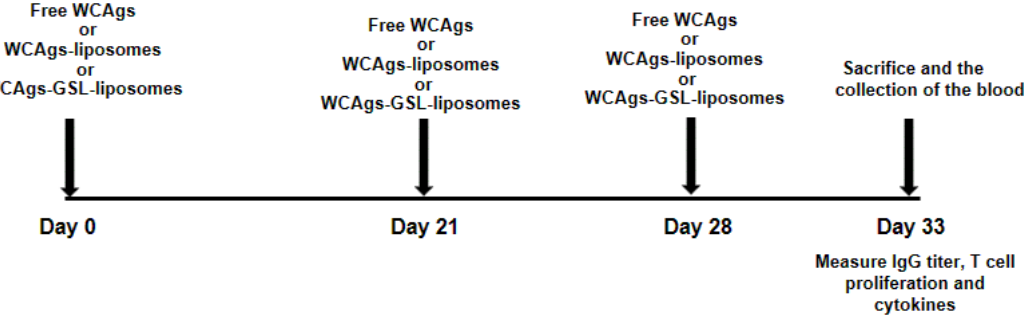
Figure 10. Schematic illustration of the immunization schedule in immunocompetent mice.